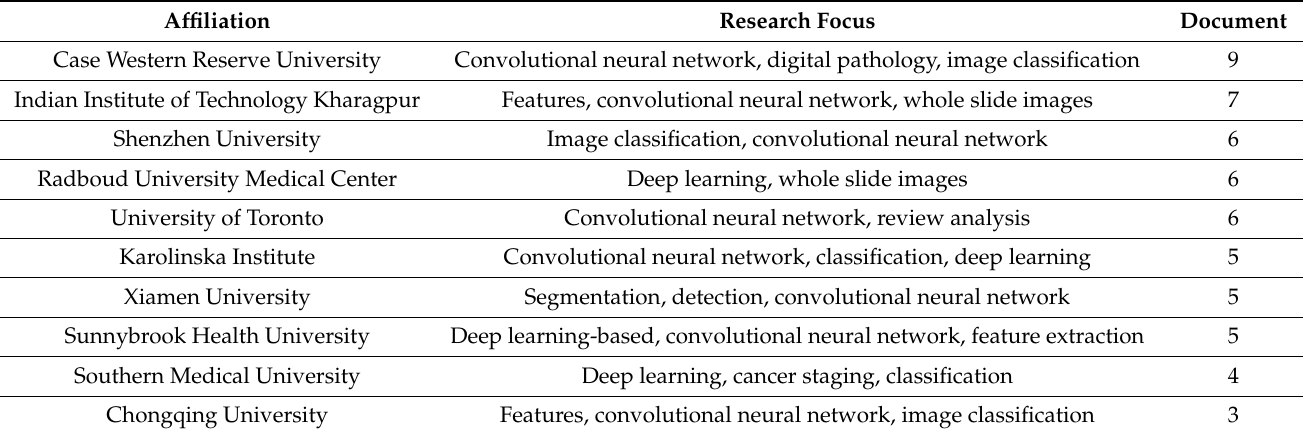
Table 5. Research institutes and their research